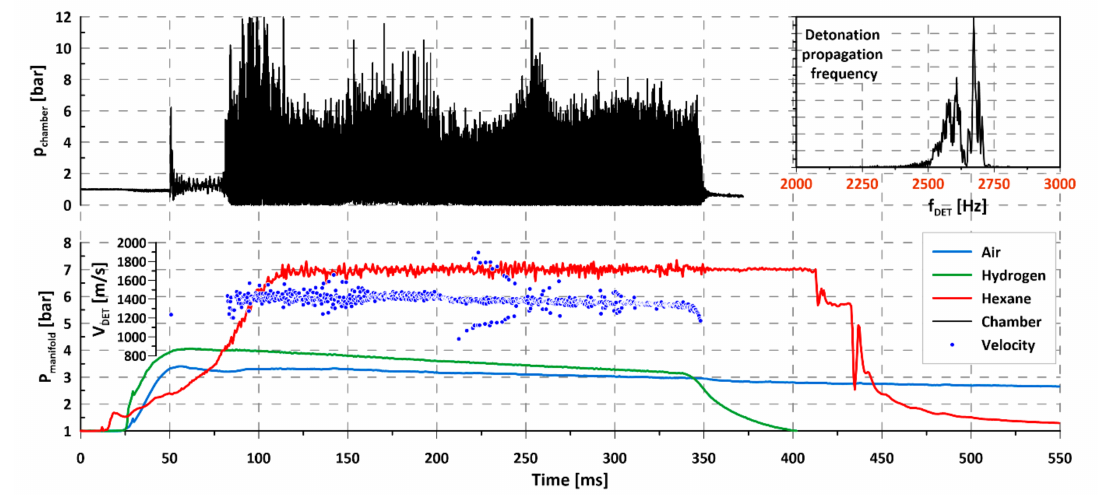
Figure8. Propagationofrotatingdetonationforliquidhexane(C 6 H 14